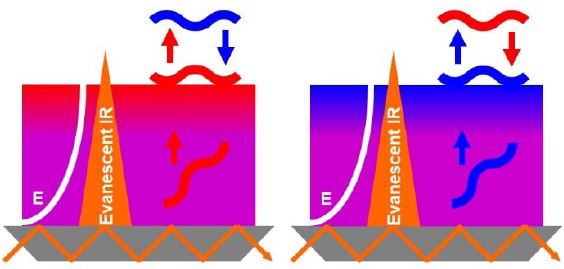
Figure 6. Scheme of the scenario whereby PEM is in contact to either the cationic PLL or anionic CS solution, and of the ATR-FTIR detection modalities concerning diffusion towards or away from the outermost PEM region.